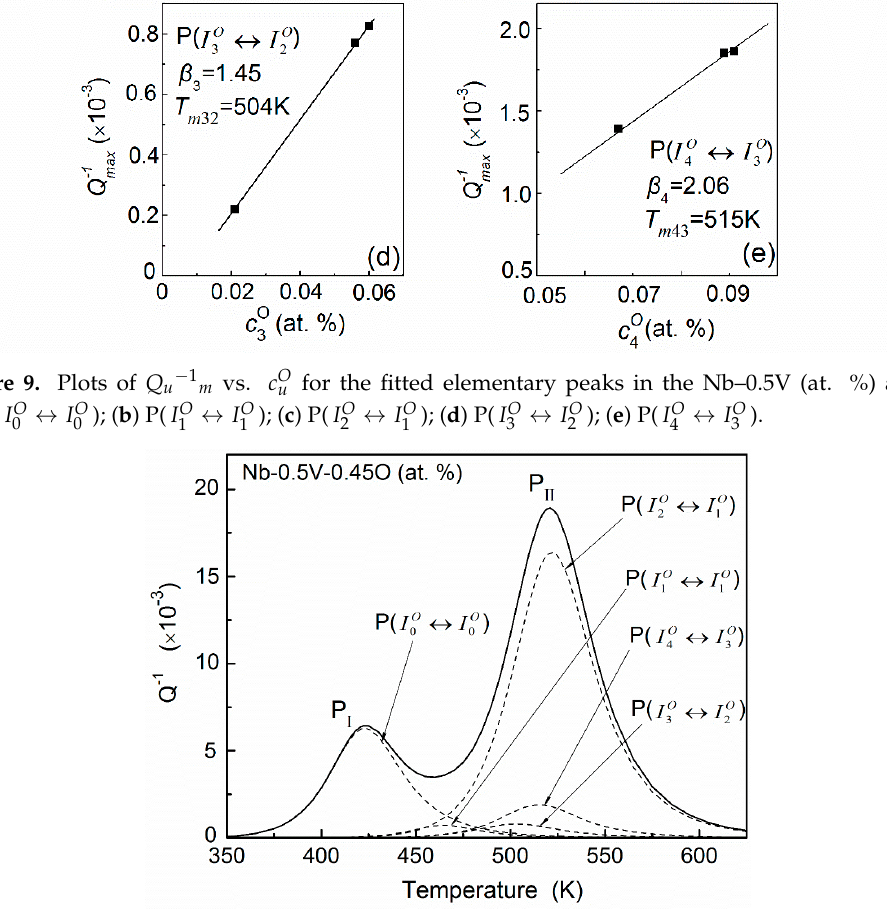
Figure 10. The calculated relaxation curve for the Nb–0.5V–0.45O (at. %) system. A notable peak P I can be determined in this system although the oxygen concentration is lower than that of vanadium